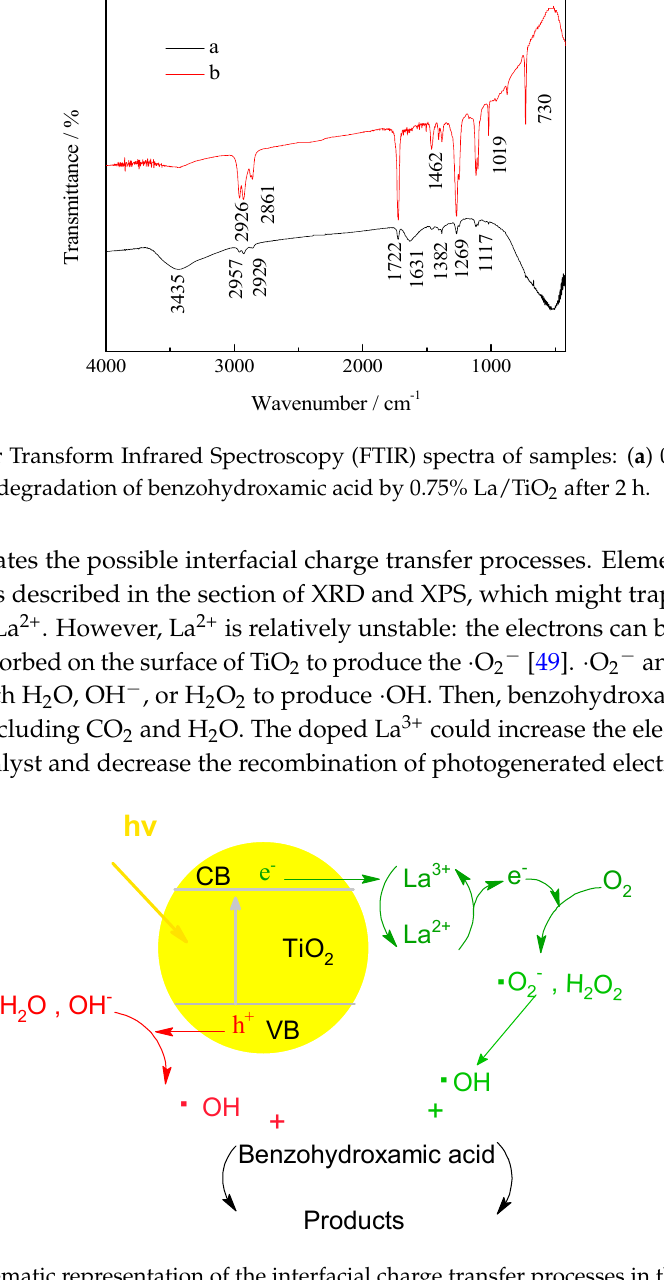
Figure 12. Schematic representation of the interfacial charge transfer processes in the La/TiO 2 .